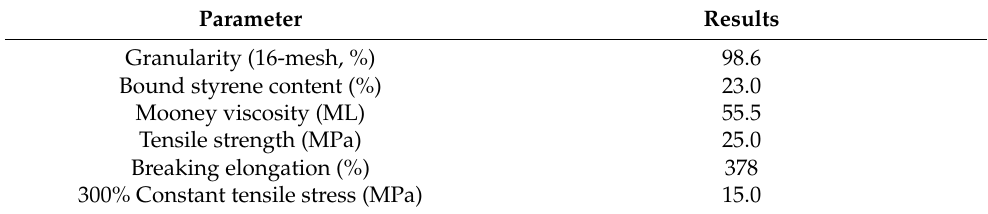
Table 2. Basic technical indexes of SBR.